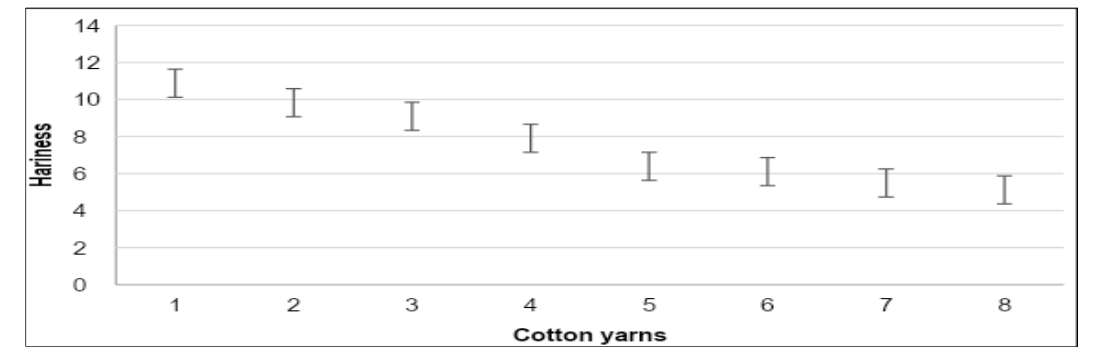
Fig. 5: Twist and hairiness of the